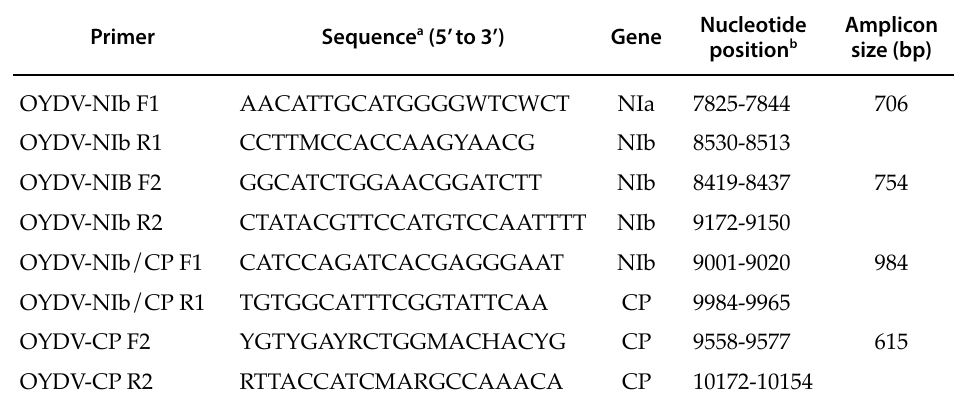
Table 1. Newly designed primers used for NIb and CP gene amplification and sequencing of OYDV isolates.